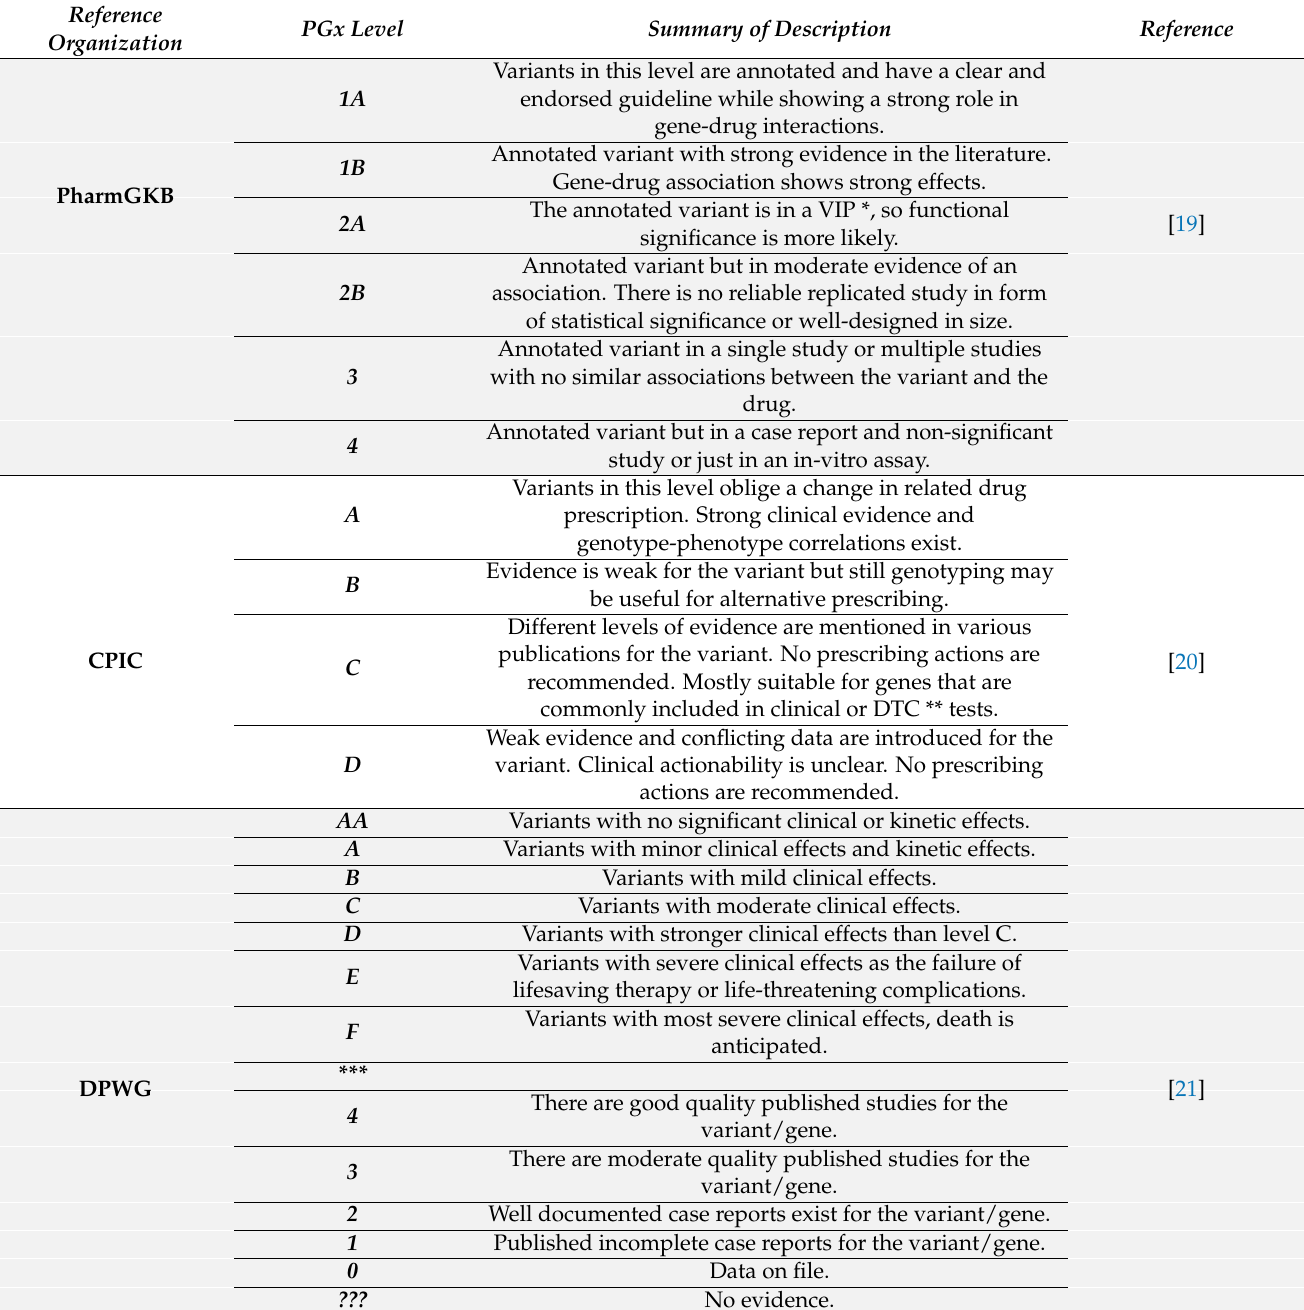
Table 1. Different levels of clinical relevance for pharmacogenomics (PGx) variants in reference organizations.